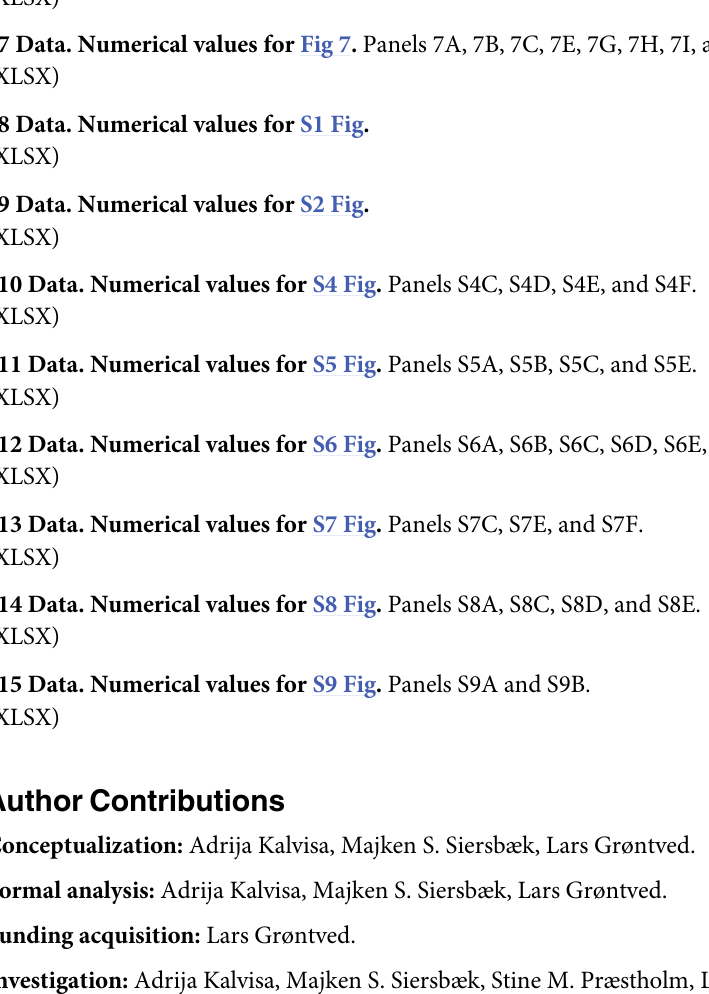
S6 Data. Numerical values for Fig 6. Panels 6A, 6B, 6C, 6D, 6E, 6F, 6G, 6I, and 6J. (XLSX) S7 Data. Numerical values for Fig 7. Panels 7A, 7B, 7C, 7E, 7G, 7H, 7I, and 7J. (XLSX) S8 Data. Numerical values for S1 Fig. (XLSX) S9 Data. Numerical values for S2 Fig. (XLSX) S10 Data. Numerical values for S4 Fig. Panels S4C, S4D, S4E, and S4F. (XLSX) S11 Data. Numerical values for S5 Fig. Panels S5A, S5B, S5C, and S5E. (XLSX) S12 Data. Numerical values for S6 Fig. Panels S6A, S6B, S6C, S6D, S6E, S6F, and S6G. (XLSX) S13 Data. Numerical values for S7 Fig. Panels S7C, S7E, and S7F. (XLSX) S14 Data. Numerical values for S8 Fig. Panels S8A, S8C, S8D, and S8E. (XLSX) S15 Data. Numerical values for S9 Fig. Panels S9A and S9B.